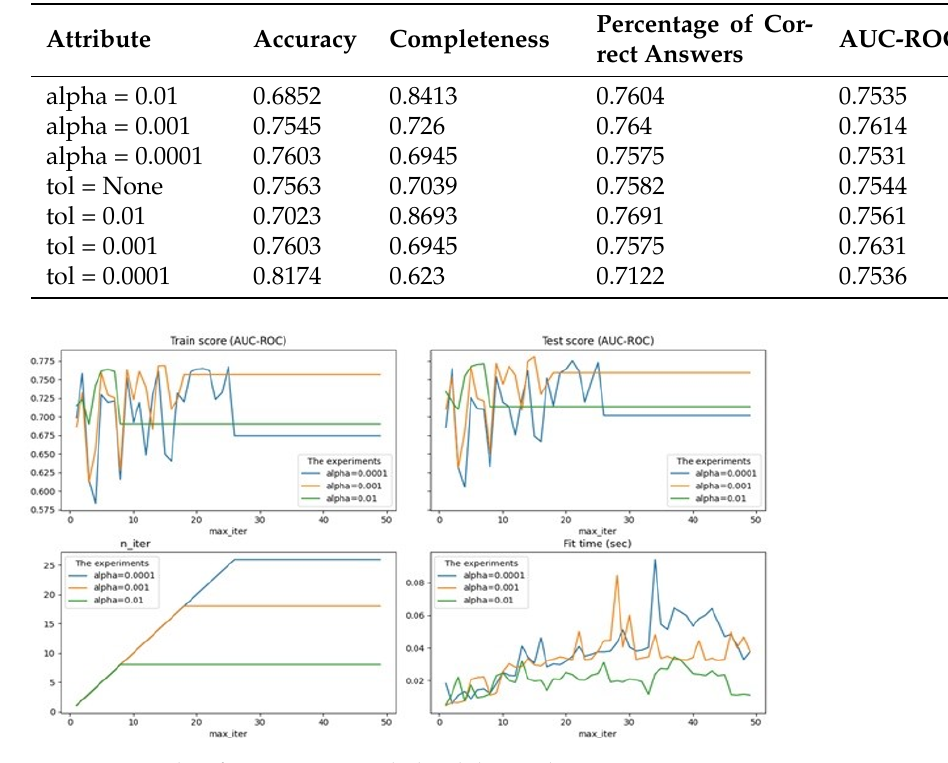
Figure 1. Results of experiments with the alpha attribute.